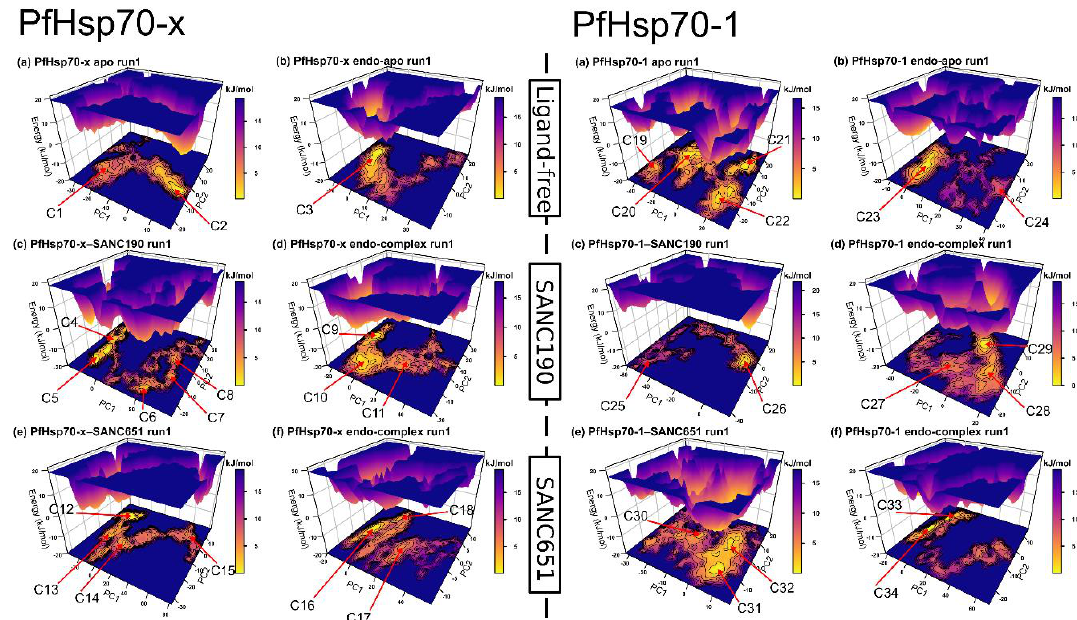
Figure 6. Gibbs free energy landscapes illustrating conformation equilibrium observables as a function of PC1 and PC2. Colors range from yellow (Gibbs free energy minima) to purple (Gibbs free energy maxima). Each contour ring represents a change in the Gibbs free energy by 1 kJ / mol. Conformations visited (conformers) during simulations were labeled from C1–C30.